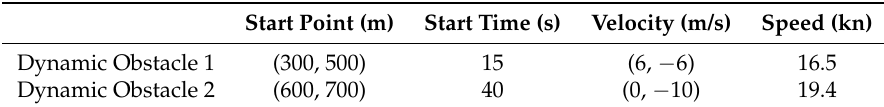
Table 2. The information of the dynamic